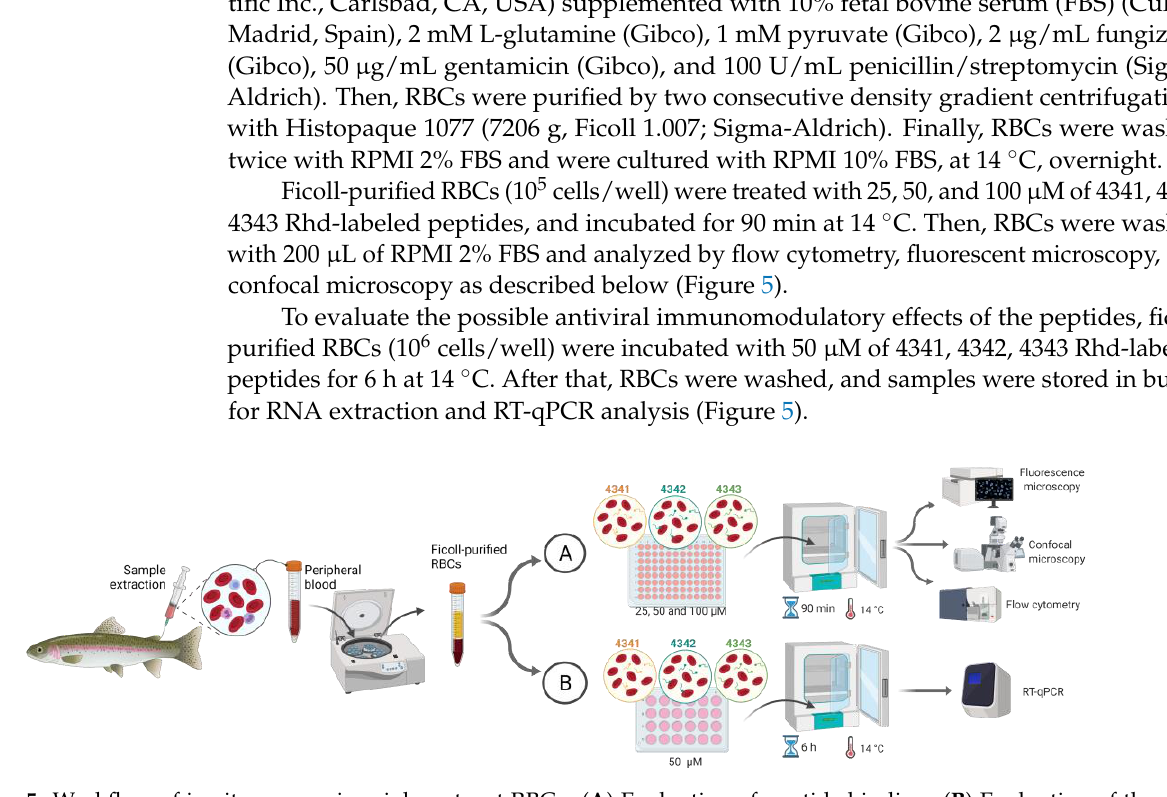
Figure 5. Workflow of in vitro assays in rainbow trout RBCs. ( A ) Evaluation of peptide binding. ( B ) Evaluation of the immune response modulation by the peptides. Created with BioRender.com (accessed on 21 October 2021).